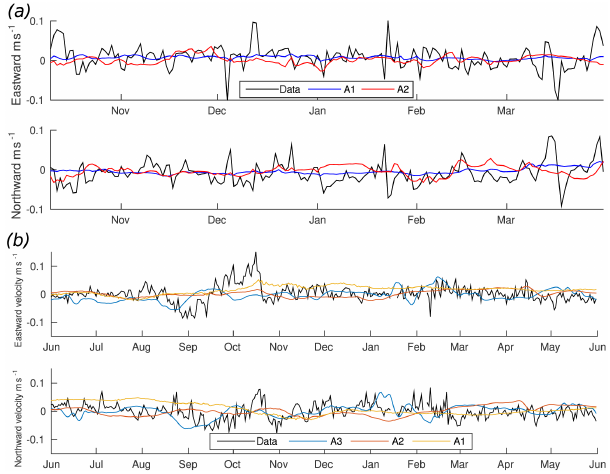
Figure 10. Gas exchange estimated model outputs of wind and sea ice speed at locations P1: 77.4 ◦ N, 143.6 ◦ W, P2: 74.8 ◦ N, 163.5 ◦ W and P3: 70.59 ◦ N, 159.4 ◦ W from January 2006 to December 2012, Areas enclose the outputs around the mean and two standard devi- ation. The size of the points demonstrate the magnitude of the gas exchange velocities normalized by sea ice